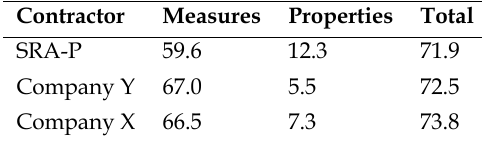
Table 6. Potential contractors submitted offer to VMN (in million